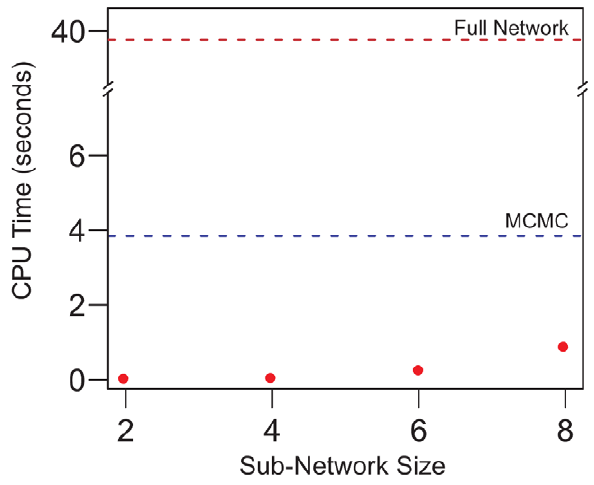
Figure 3. Average CPU time taken for calculating the pseudo- likelihood on toy networks. The pseudo-likelihood of going from the network H 1 to the network H 2 (Figure 1) was calculated conditioned on H 1 for different sub-network sizes. The times taken for calculating the pseudo-likelihood averaged across three runs are shown in red. The horizontal lines show the average CPU time taken using the MCMC approach based on path sampling described in Mithani et al. [9] with 11,000 iterations including first 1,000 iteration as burn-in period (blue dashed line) and by exponentiating the full network (brown dotted